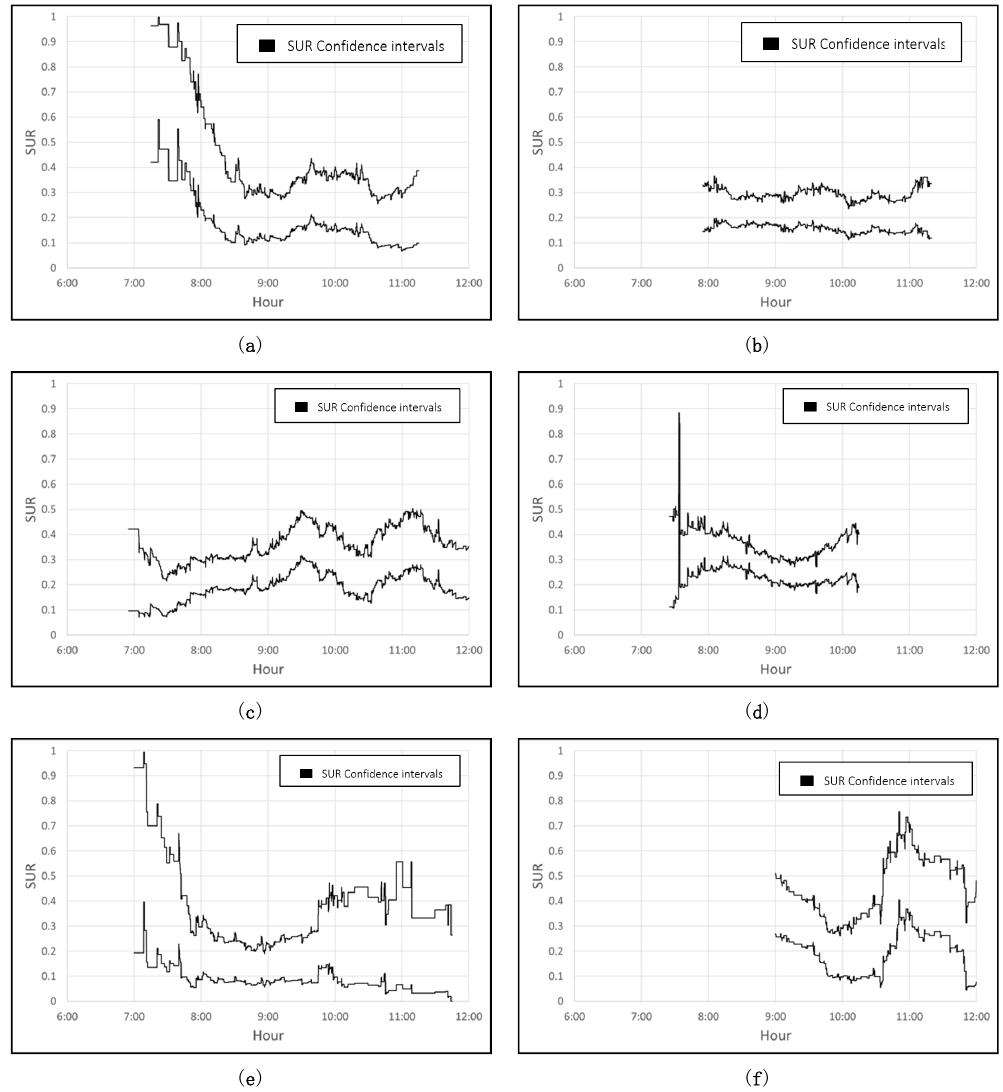
Figure 7. Confidence intervals for the node-aggregated SUR estimations: ( a ) Observation code 1.1; ( b ) Observation code 2.4; ( c ) Observation code 3.3; ( d ) Observation code 4.4; ( e ) Observation code 5.2; ( f ) Observation code 6.1.